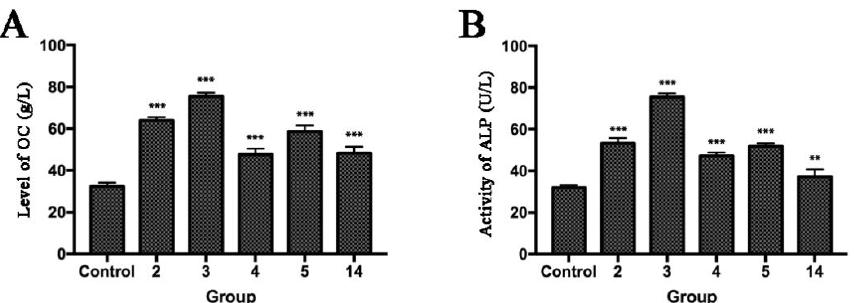
Figure 5. Promotion effect of 90 μg/mL of 2 , 3 , 4 , 5 , and 14 on OC and ALP expression in MC3T3-E1 cells: ( A ) OC levels; and ( B ) ALP activities. All values are represented as mean ± SD, n = 5. ** p < 0.01 versus the control. *** p < 0.001 versus the control.